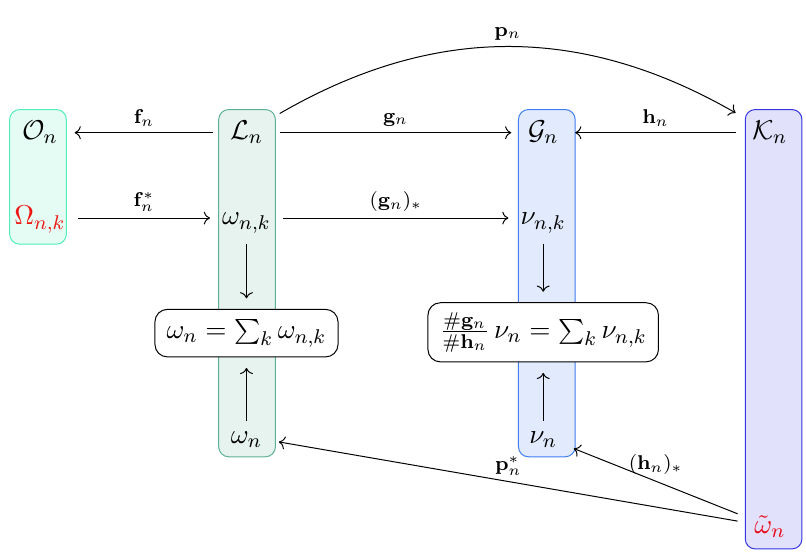
Figure 2 . Relations between the kinematic spaces and the various differential forms on them defined in this section. We highlight the canonical forms of the momentum amplituhedron Ω n,k and of the associahedron ˜ ω n